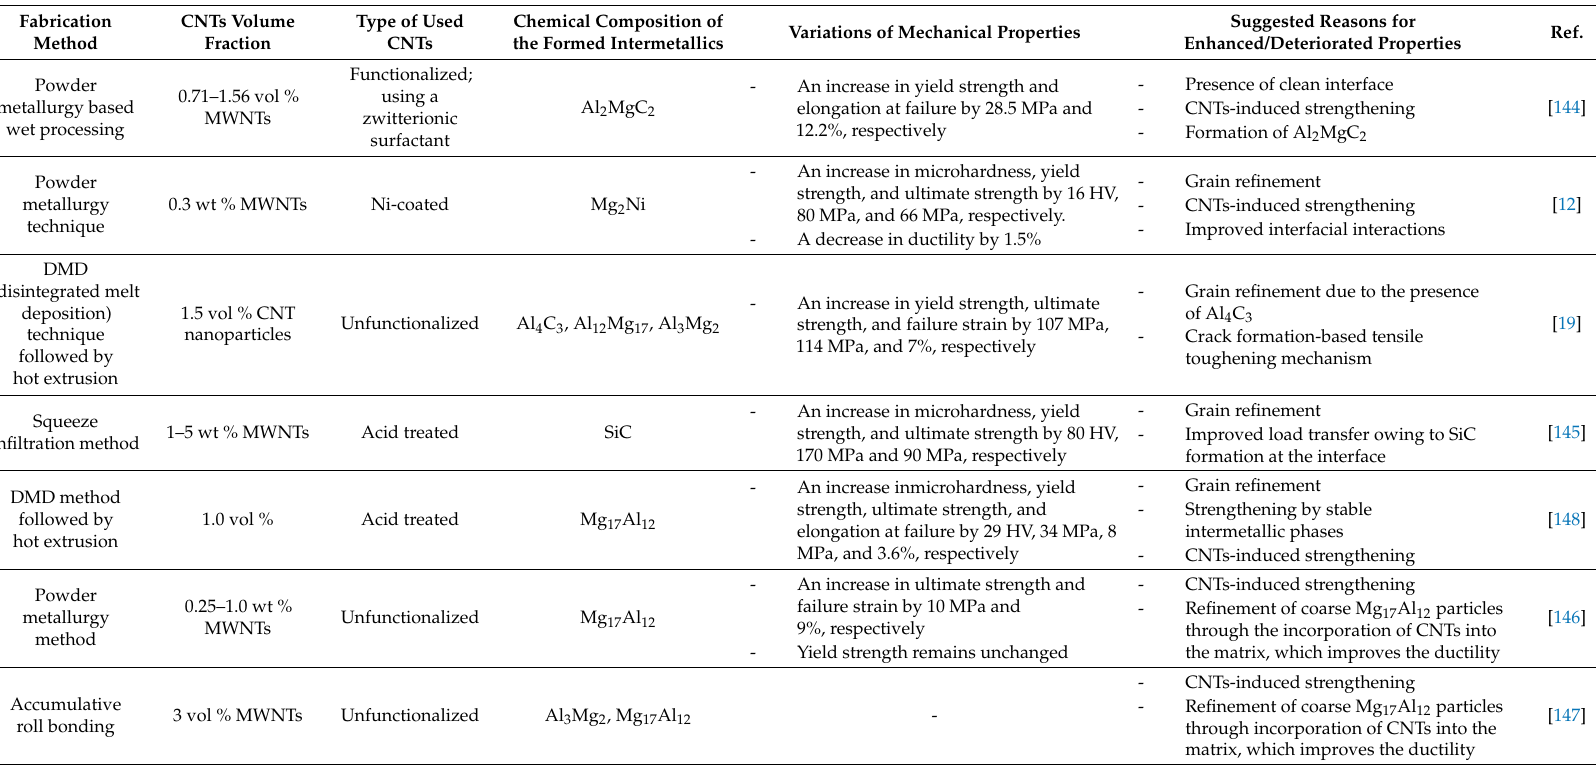
Table 4. An overview of fabrication method, formed intermetallic compounds, and mechanical properties of CNT-reinforced Mg matrix